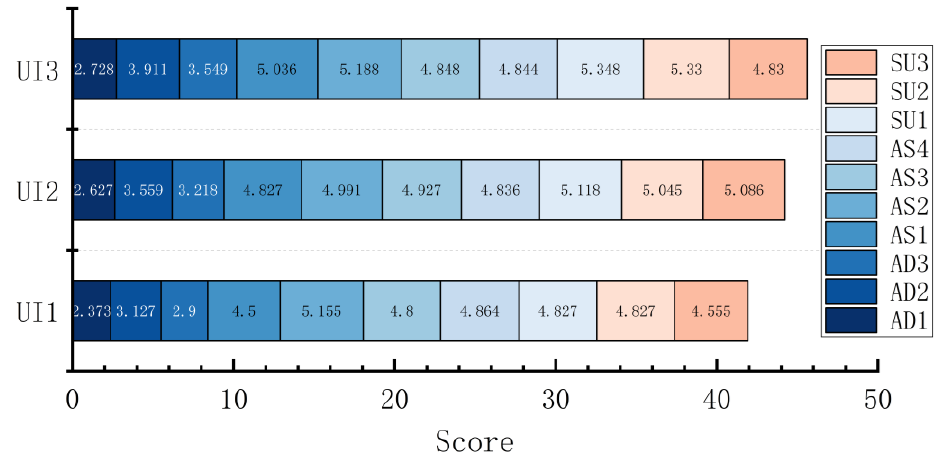
Figure 15. Ten sub-dimension scores of SART of each UI level.